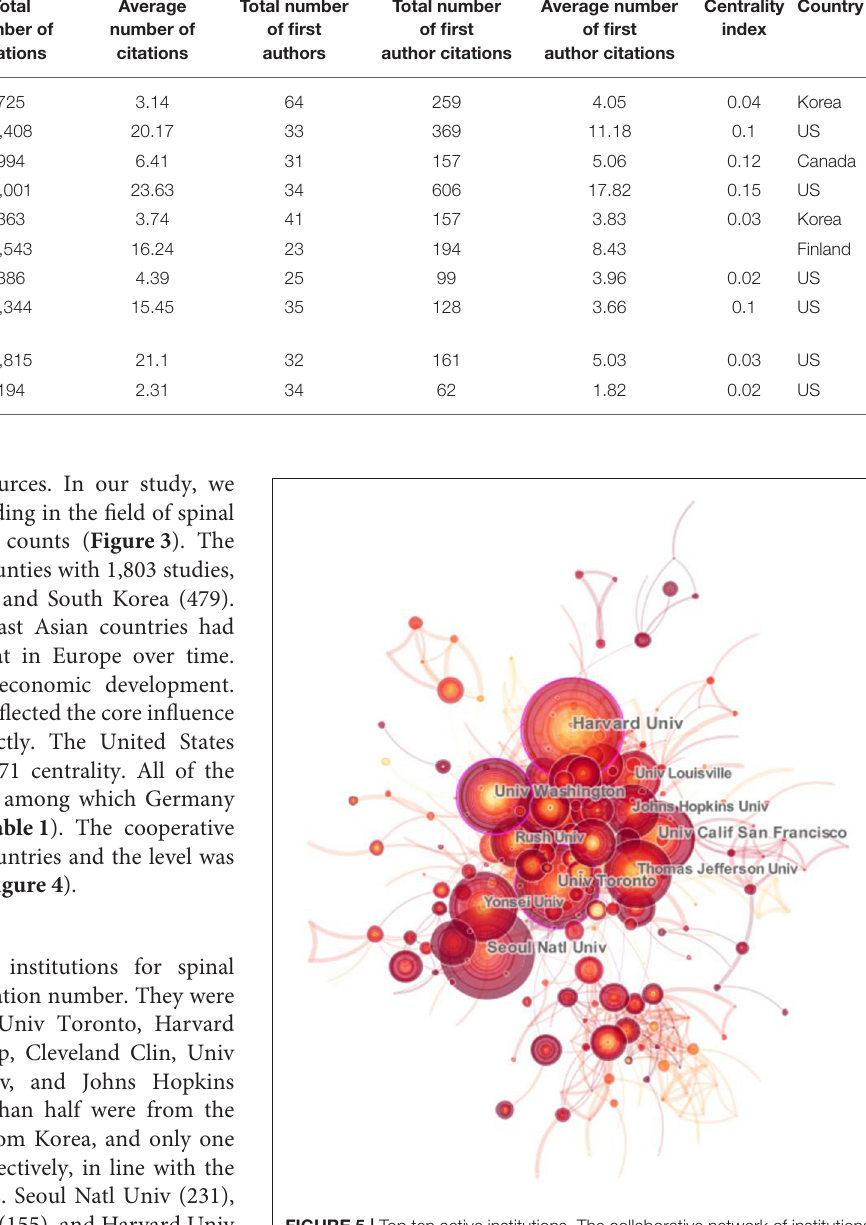
FIGURE 5 | Top ten active institutions. The collaborative network of institutions involved in spinal stenosis